Question: In one sentence, what is this figure communicating?
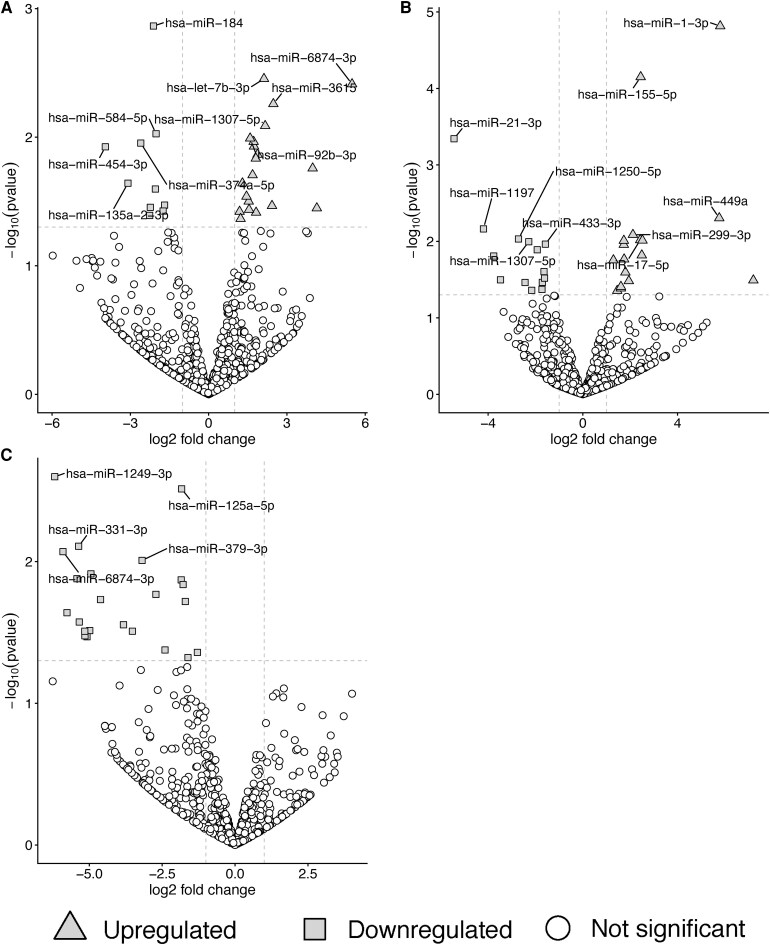
Answer: FTD mutation BDsEV miRNA cargo microenvironment variation compared with other FTD mutation samples. Volcano plots displaying the human (hsa) miRNA in all FTD samples after differential expression, where each graph shows ( A ) FTD- GRN versus FTD- MAPT and FTD- C9orf72 , ( B ) FTD- MAPT versus FTD- GRN and FTD- C9orf72 and ( C ) FTD- C9orf72 versus FTD- GRN and FTD- MAPT , with log2FC plotted against log10 p values. DESeq2 was ran in R which applies a negative binomial generalized linear model with Wald testing (sample size n = 3, biological replicates plotted). Nominally significant upregulated (triangle plot), downregulated (square plot) and not significant (circular) miRNAs are plotted, as no miRNAs survived FDR testing (with the top 5 up and downregulated miRNA labelled). Dashed lines represent log2FC of 1 and −1 and a −log10p of 1.3 ( P < 0.05).